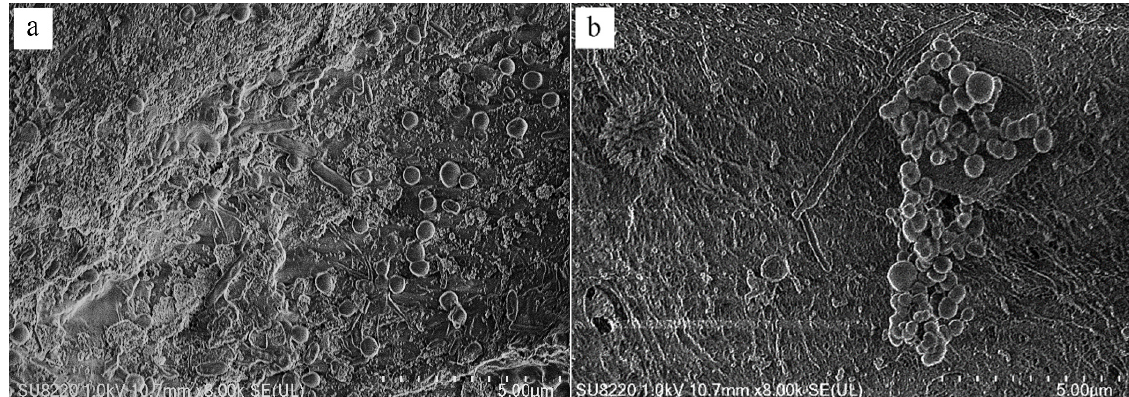
Figure 9. SEM images of biofilms located in carriers before ( a ) and after ( b ) ICPB.